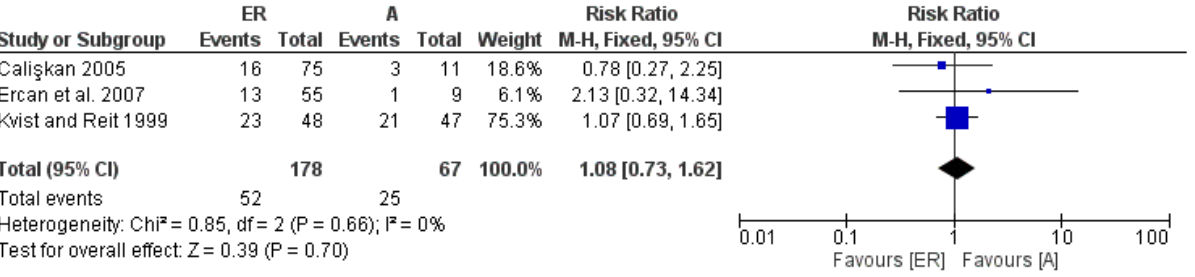
Figure 4. Forest plot of the fixed-effects model of the meta-analysis of the failure data within the 3– 4-year follow-up. RR 1.08 [ 0.73 1.62] Chi 2 = 0.85, df = 2 ( p = 0.66).